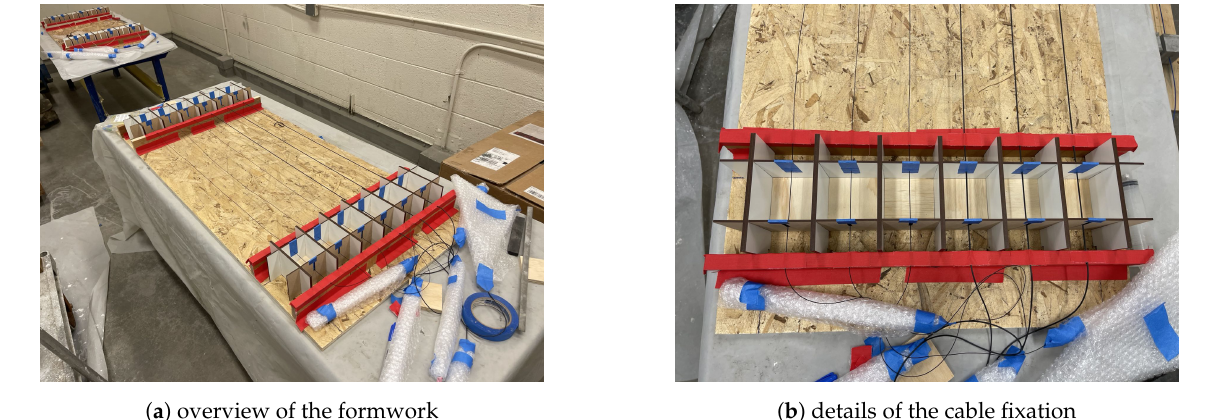
Figure 1. Formwork composed by laser cutting woods.